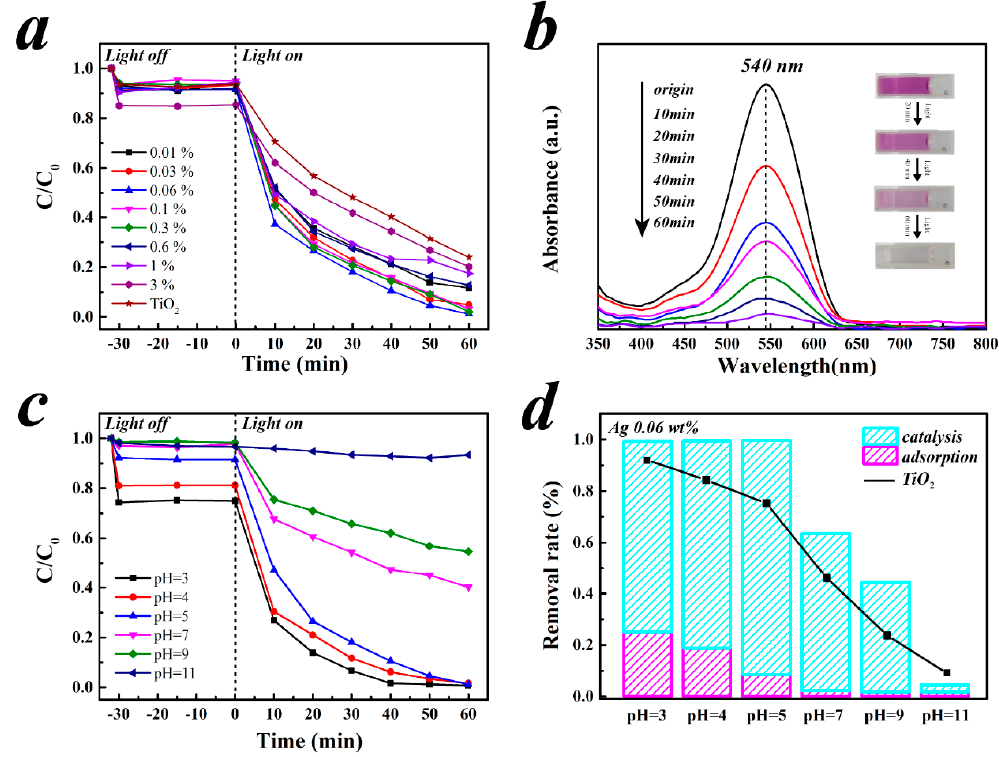
Figure 4. ( a ) Photocatalytic reduction efficiency by pure TiO 2 and Ag@TiO 2 composites with various Ag loading ratio (effect of different loading on adsorption balance before irradiation, insert); ( b ) UV-vis full wave band scanning of Cr(VI) under different irradiation times (the color change of Cr(VI) simples with different reduction time, insert); ( c ) Effect of different initial pH on Cr(VI) reduction rate; ( d ) The contribution of adsorption and photoreduction in Cr(VI) removal with different initial pH value using bare TiO 2 and Ag@TiO 2 . (Both ( b , c , d ) using the simple with 0.06 wt % Ag addition. The experimental conditions were [Cat] = 1 g/L, [Cr(VI)] 0 = 10 mg/L, 300 W and 60 min irradiation.